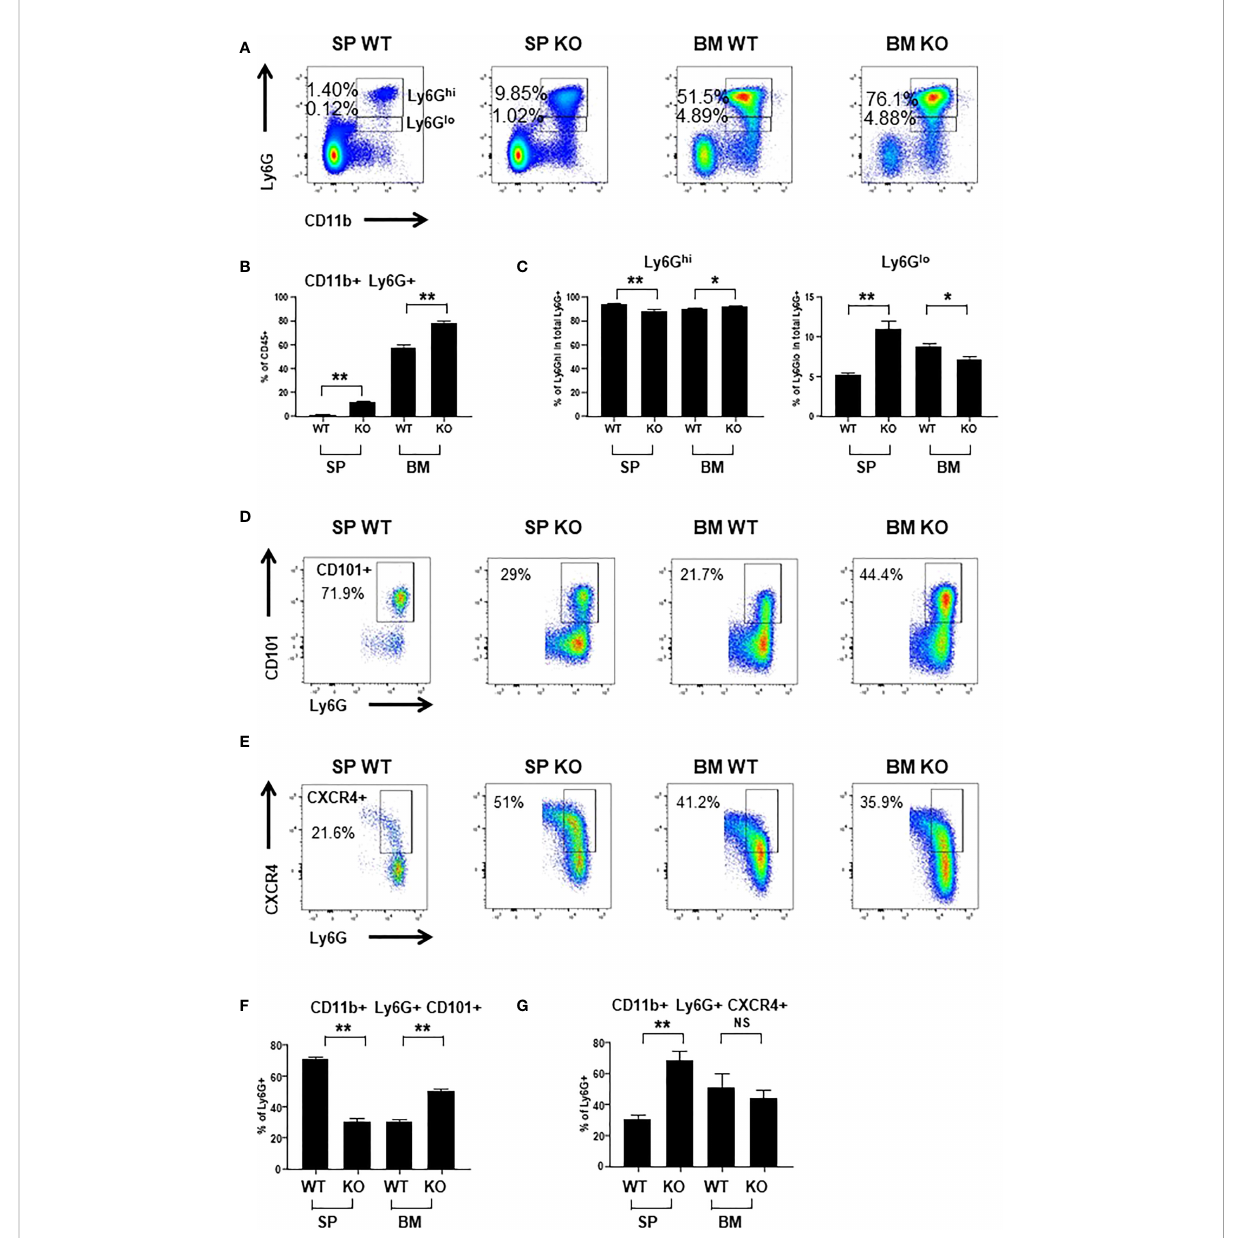
FIGURE 1 Cxcr2 knock-out decreases the percentage of mature neutrophils in the spleen. (A) Representative dot plots of the gating strategy of CD45+ CD11b + Ly6G hi and CD45+ CD11b+ Ly6G lo neutrophils among CD45+ cells in WT and Cxcr2-/- bone marrow (BM) and spleen (SP). (B) Quanti fi cation of the percentage of the total neutrophils (CD11b+ Ly6G+: sum of Ly6G hi and Ly6G lo ) in the CD45+ fraction. (C) Quanti fi cation of CD11b+ Ly6G hi cells (left panel) and CD11b Ly6G lo (right panel) in the CD11b+ Ly6G+ (Ly6G hi and Ly6G lo fractions) population. (D) Gating strategy to identify CD101+ neutrophils in the CD45+ CD11b+ Ly6G+ fraction. (E) Gating strategy to identify CXCR4+ neutrophils in the CD45+ CD11b+ Ly6G+ fraction. (F) Percentage of mature CD101+ neutrophils in the CD11b+ Ly6G+ fraction. (G) Percentage of CXCR4+ neutrophils in the CD11b+ Ly6G+ fraction. Data represent the mean ± SEM of at least 6 animals (Mann-Whitney test, NS: non-signi fi cant, *p < 0.05, **p <